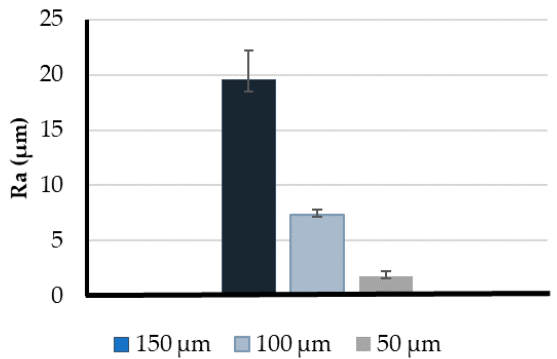
Figure 7. Comparison between the roughness parameter, Ra, at three di ff erent print resolutions. The measurements are expressed as the mean ± standard deviation according to a t -test analysis at 95% confidence interval.